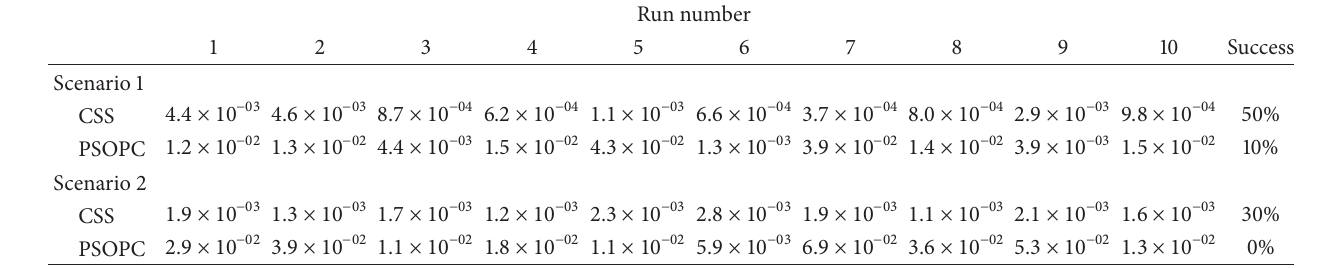
Table 10: The values of objective function of the 39-element frame for